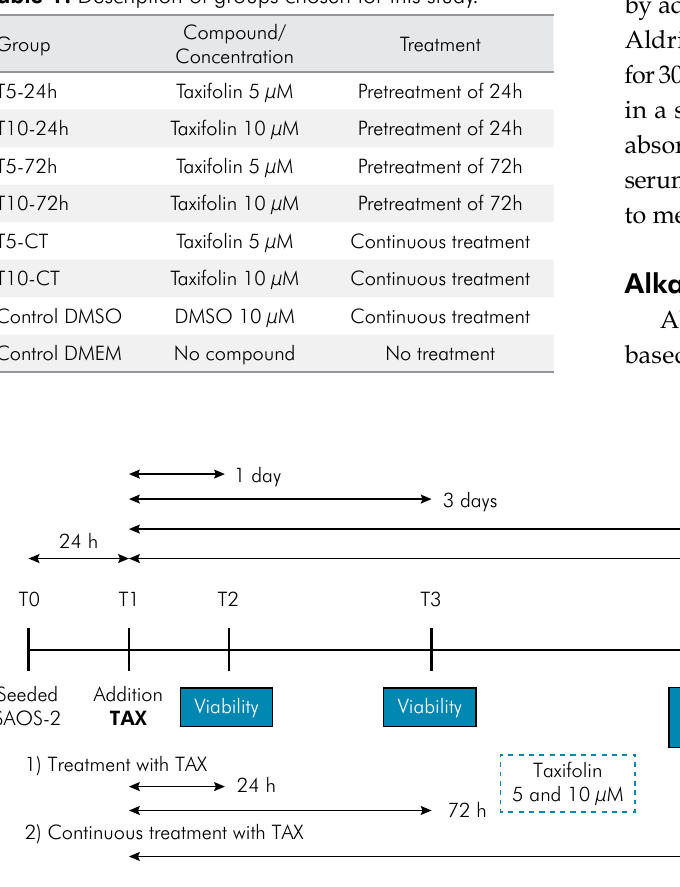
Figure 1. Experimental design of the